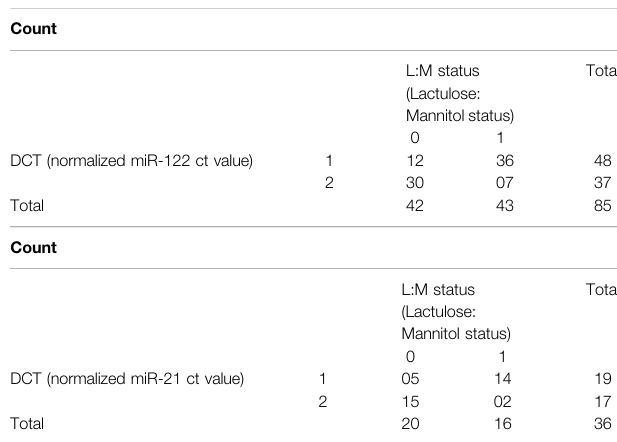
TABLE 2 | (A) Normalized miR-122 ct value (DCT) *Lactulose: Mannitol ratio(L:M) Status Crosstabulation. L:M status 1 indicates children with (L:M > 0.09) considered to have increased IIP and L:M status 0 indicates children with (L:M ≤ 0.09), considered to have NIP. DCT 1 indicates normalized miR-122 ct value ≤ 9.8 and DCT 2 indicates normalized miR-122 ct value > 9.8. (B) Normalized miR- 21 ct value (DCT)*Lactulose: Mannitol ratio (L:M) status crosstabulation. L:M status 1 indicates children with (L:M > 0.09) were considered to have increased IIP and 0 indicates children with (L:M ≤ 0.09), were considered to have NIP. DCT 1 indicates normalized miR-21 ct value ≤ 9.8 and DCT 2 indicates normalized miR-21 ct value >